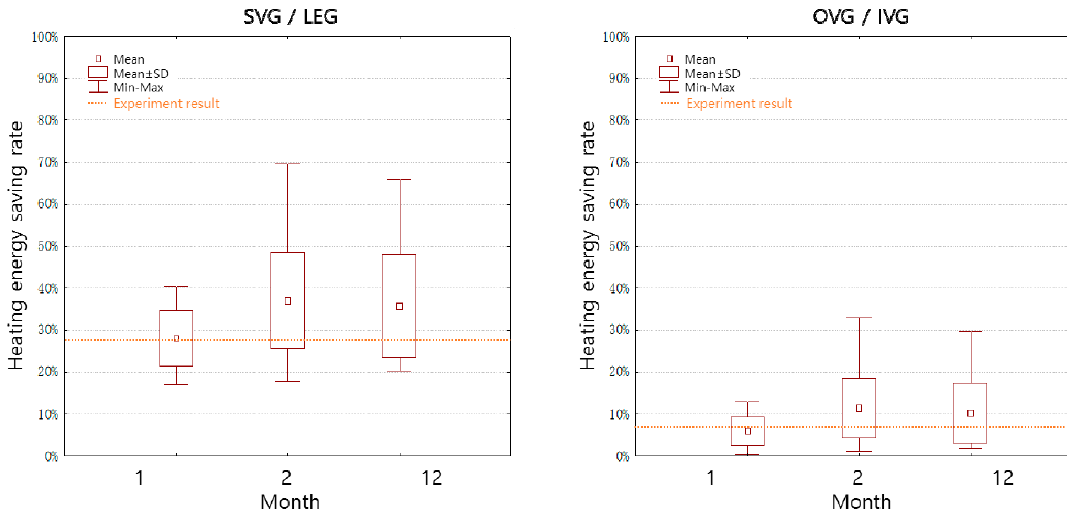
Figure 13. Comparison of standard deviation of heating energy saving rate and experiment results.